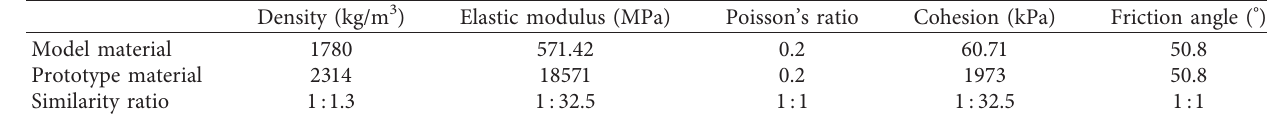
Table 4: Physical parameters of the linings.